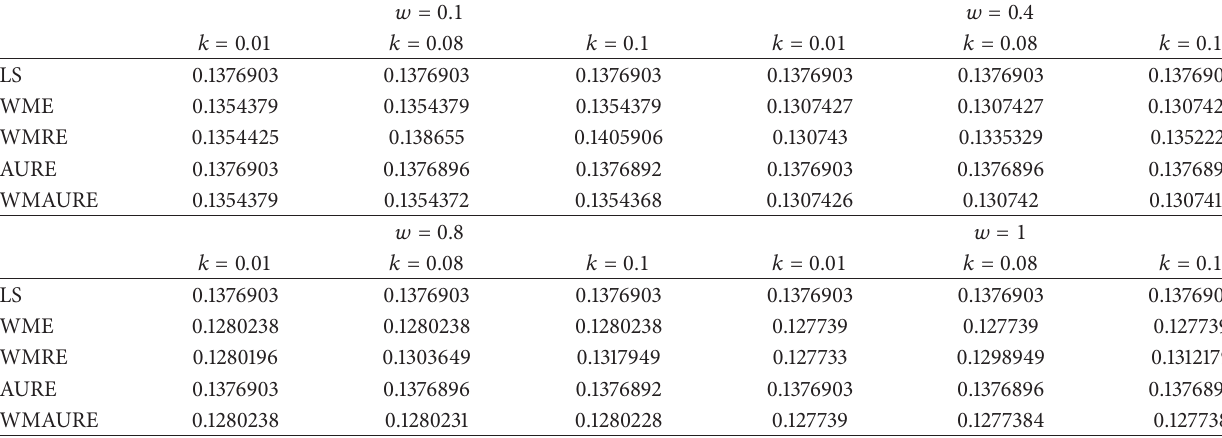
Table 5: Estimated MSE values of the WME, WMRE, AURE, and WMAURE when 𝜌 = 0.99